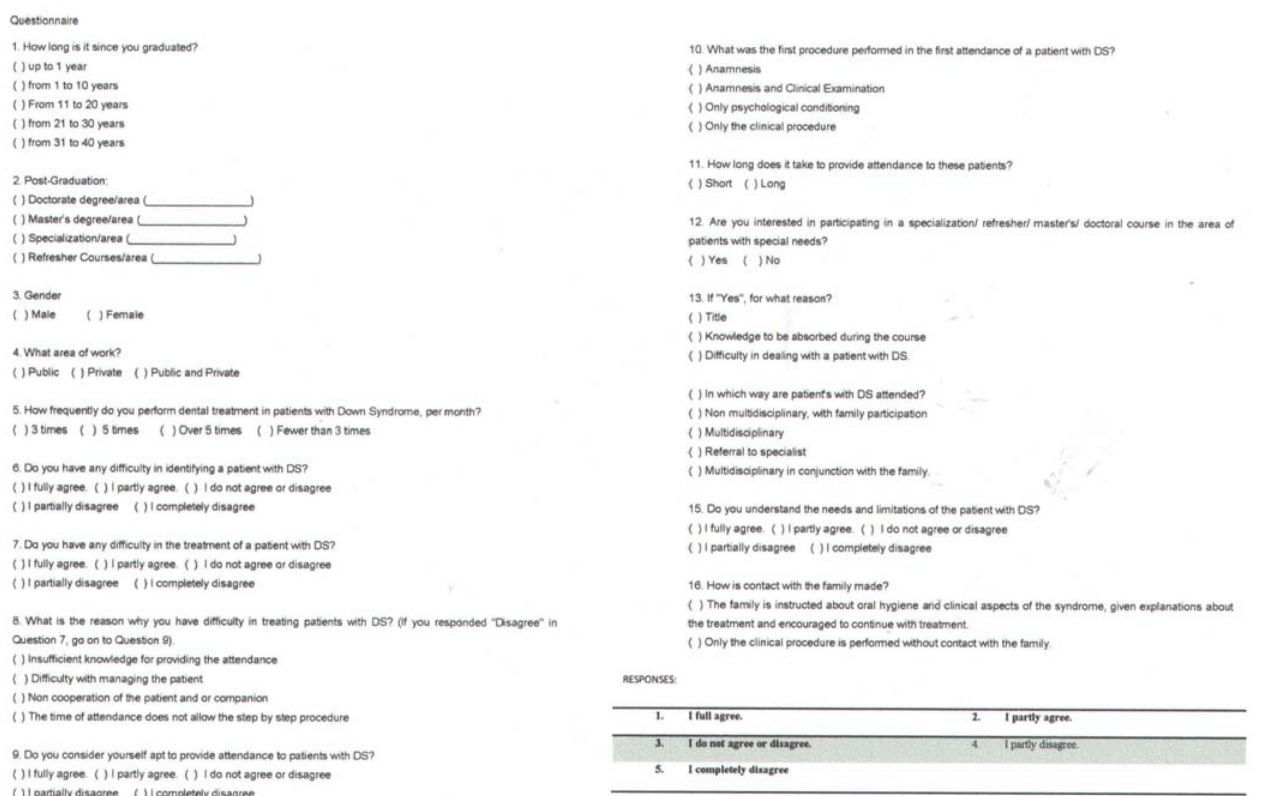
Fig. 1. Questionnaire Braz J Oral Sci.